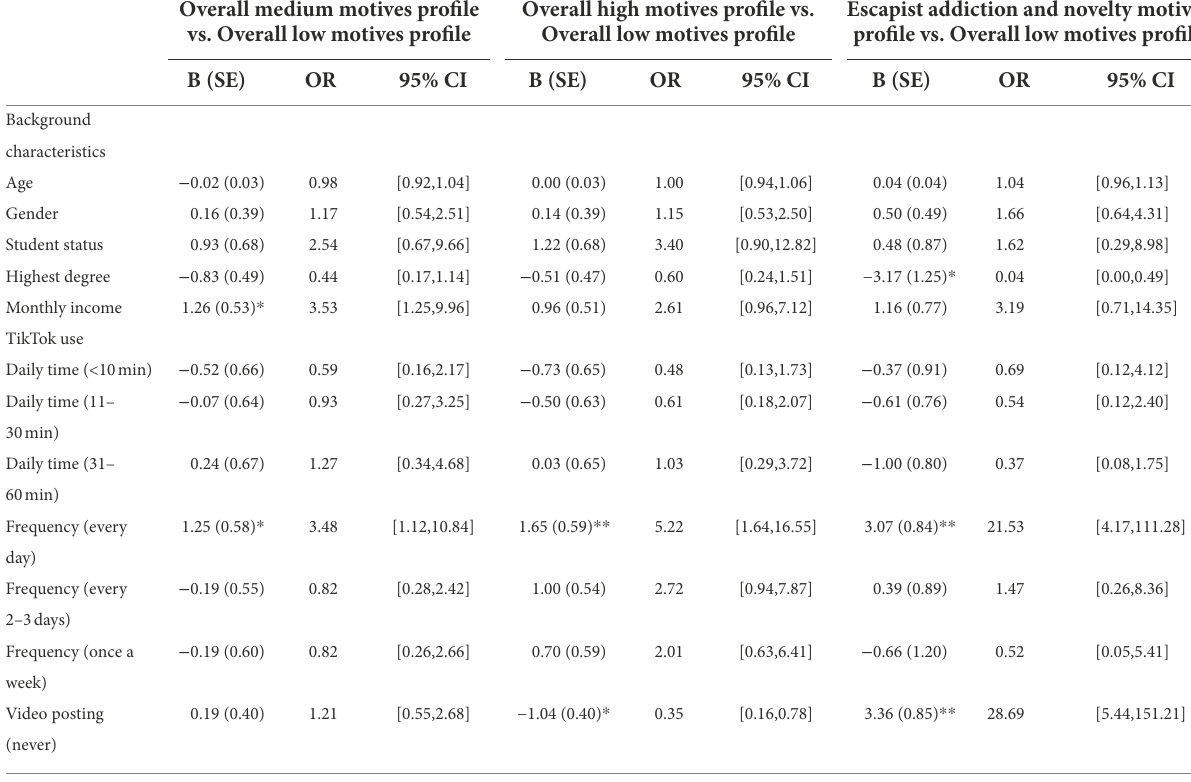
TABLE 5 Multinomial logistic regression results predicting profile membership. Overall medium motives profile vs. Overall low motives